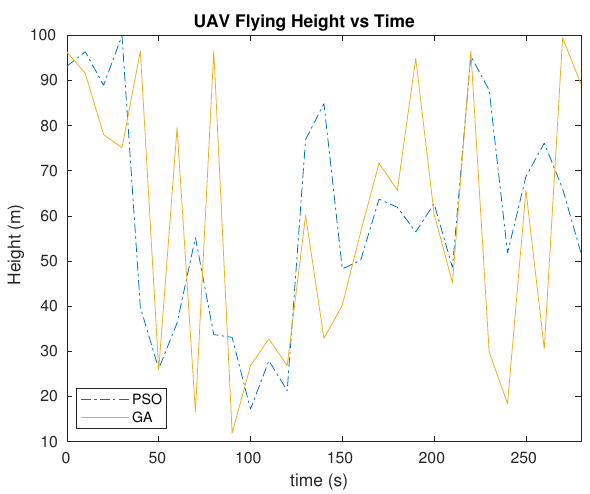
Figure 8. Flying height variations throughout time for the UAV.